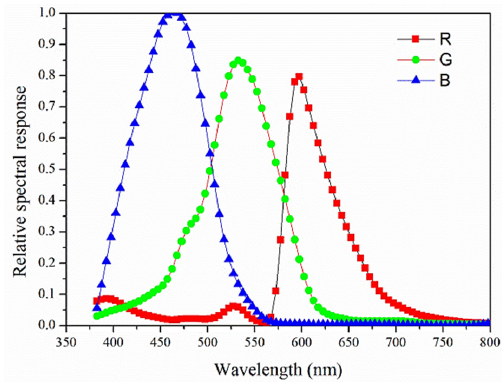
Figure 9. Spectral response curves of the R, G, and B bands of the color digital camera (Type: Manta G-504).